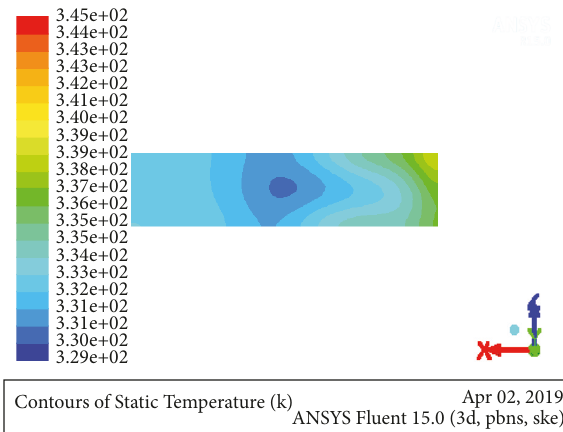
Figure 30: The bottom temperature distribution of support under adiabatic boundary condition.